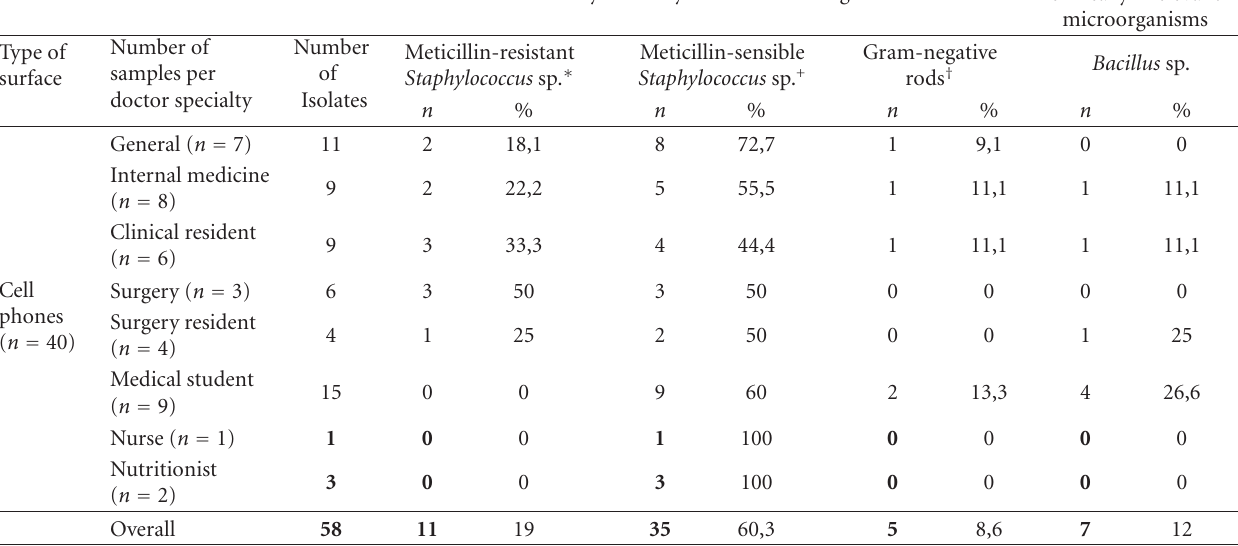
Table 3: Distribution of bacterial isolates from cell phones. Potentially clinically relevant